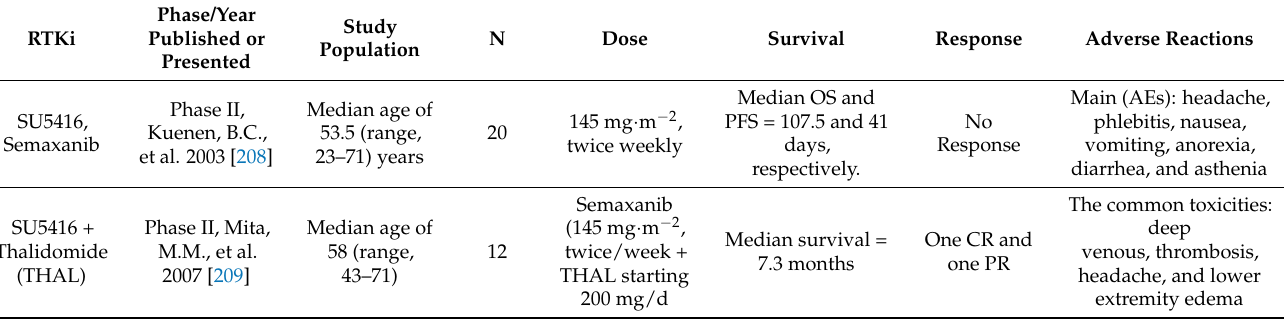
Table 10. Melanoma clinical trials with VEGFR